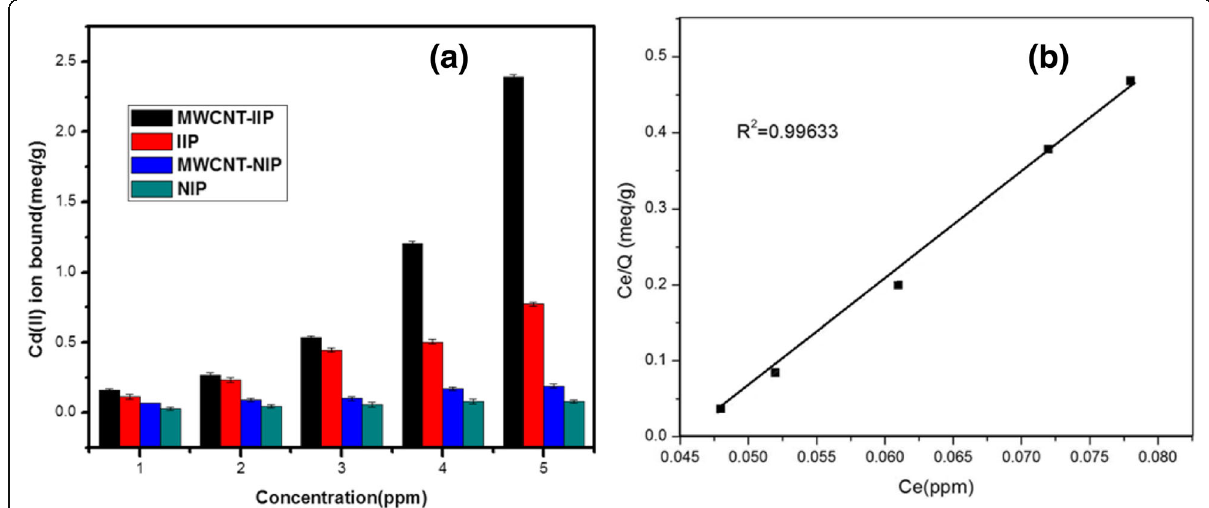
Fig. 15 a Effect of concentration on the adsorption of Cd(II) ion on MWCNT-IIP, IIP, MWCNT-NIP, and NIP and b Langumuir adsorption isotherm of Cd(II) ion